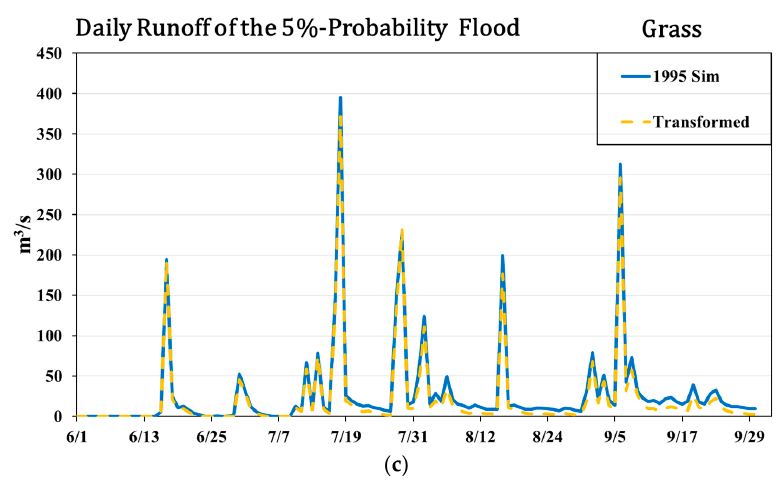
Figure 6. In every panel, the original is the result under the 1995 land use simulated by SWAT model,